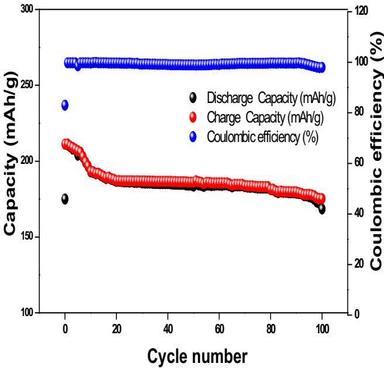
Cycling performance of IL-β-MNV nanorods at 1C rate.